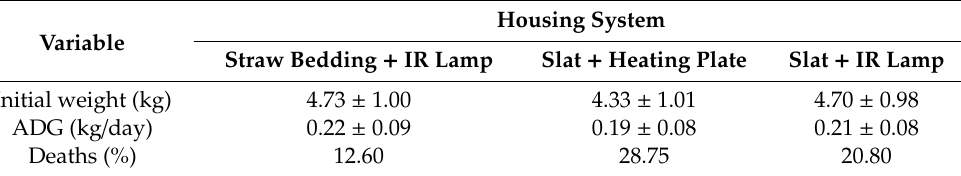
Table 6. Variation of the initial weight, average daily gain (ADG) and percentage of deaths as a function of the lamb housing system.